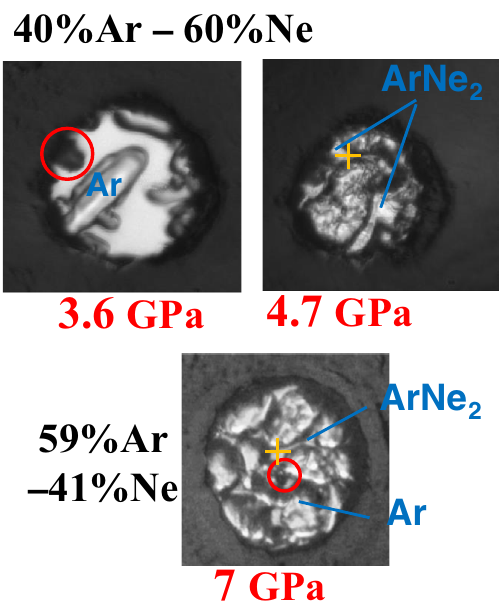
Figure 2. pictures of the sample cavities for runs 2 and 3. The two pictures for run 3 have been taken on pressure increase. Gold pressure marker is circled in red, and yellow crosses indicate the position of XRD beam where most of exposures have been performed. It is in ArNe 2 , at the edge of an argon